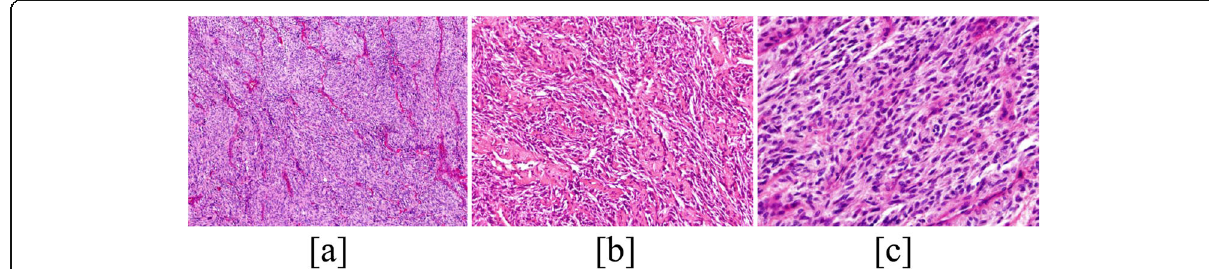
Fig. 1 Histiological findings. Tumor show predominantly monomorphic spindle cells, arranged in fascicles or interweave pattern ( a ), separated by fibrovascular amyloid stroma ( b ) (H&E, original magnification, × 200). Tumor cells show short or long spindle nuclei, abundant cytoplasm and rare mitoses ( c ) (H&E, original magnification, ×